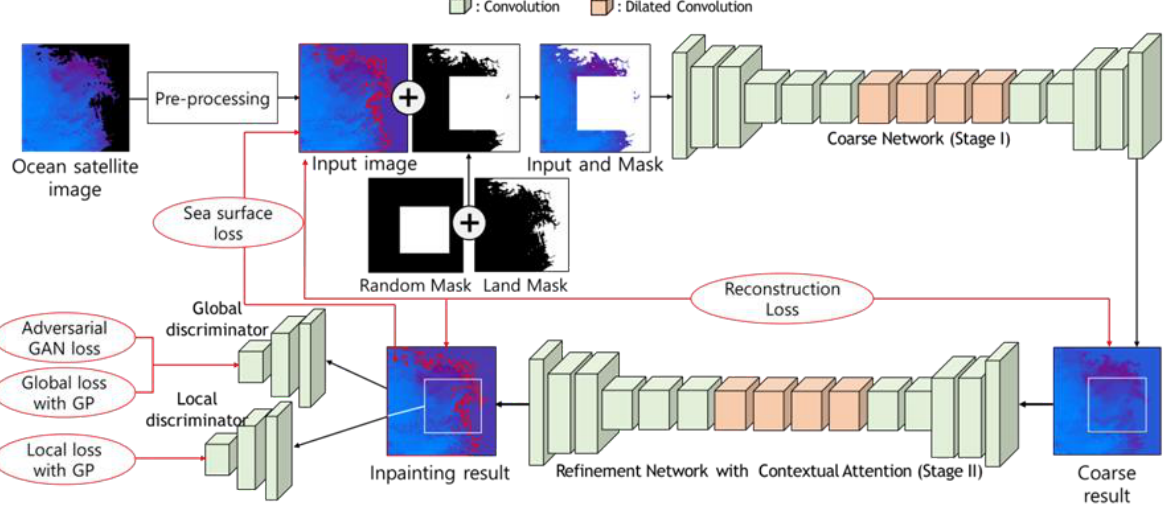
Figure 4. Overall process of constructing our generative inpainting network (GIN) to restore satellite sea surface temperature. It consists of a coarse network and refinement network, as well as two auxiliary discriminant networks that are used only for training the coarse and refinement networks; hence, they are not used during the testing. The coarse network takes the entire ocean satellite image as input, while the refinement network takes only a local region of the inpainted region as input. Note that the coarse network is trained with reconstruction and sea surface losses explicitly, while the refinement network is trained with adversarial GAN loss, and global and local losses with gradient penalty.